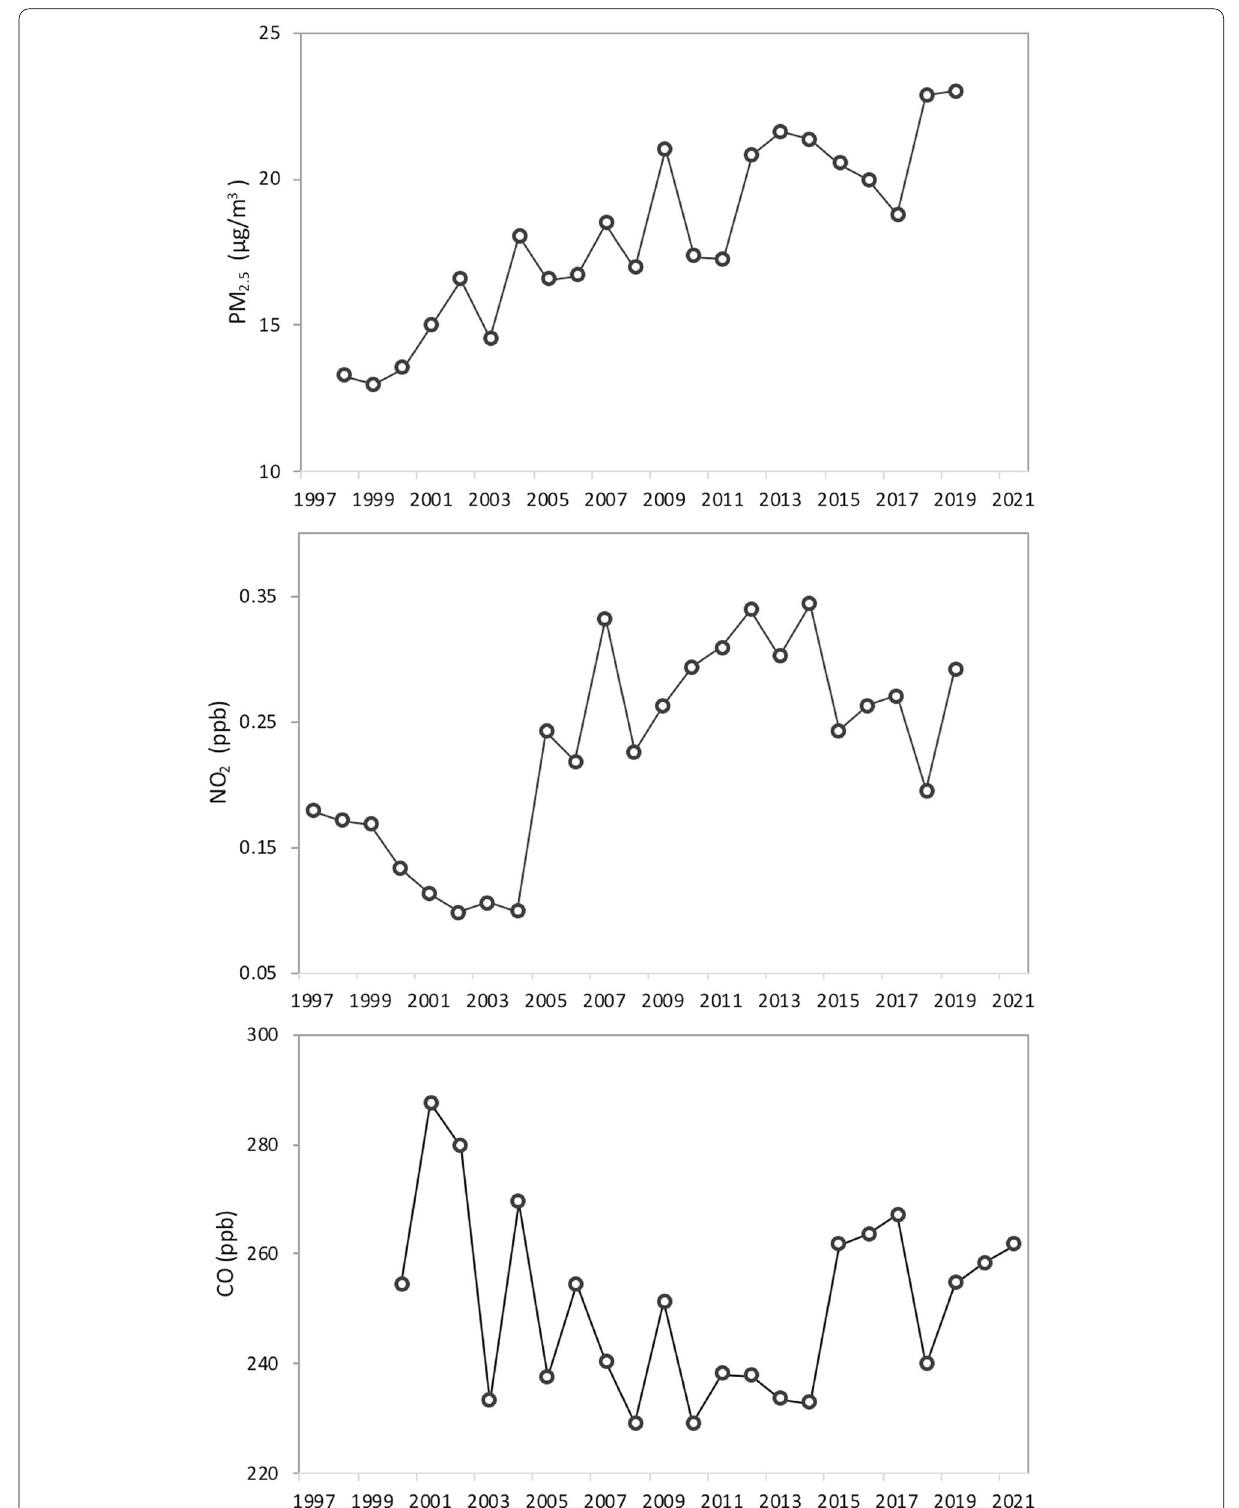
Fig. 3 Changes in PM 2.5 , NO 2 , and CO concentrations in Yangon from 1997 to 2021. While the concentrations of CO decreased from the late 1990s, the concentrations of NO 2 and PM 2.5 increased from the late 1990s to